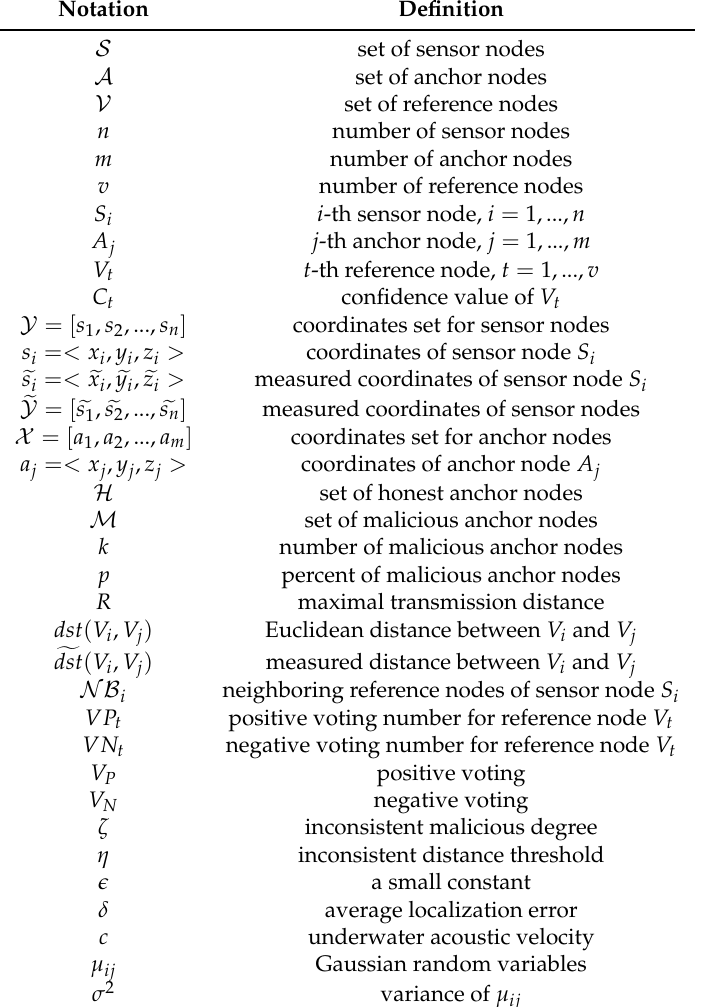
Table 1. List of